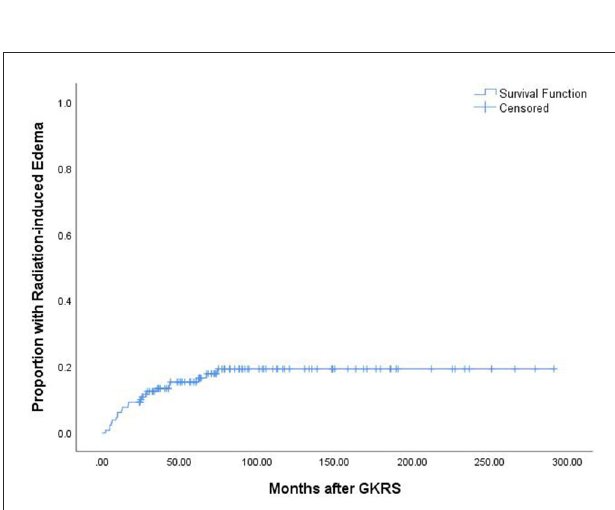
FIGURE6 The Kaplan–Meier curve of proportion with radiation-induced edema in the entire series.